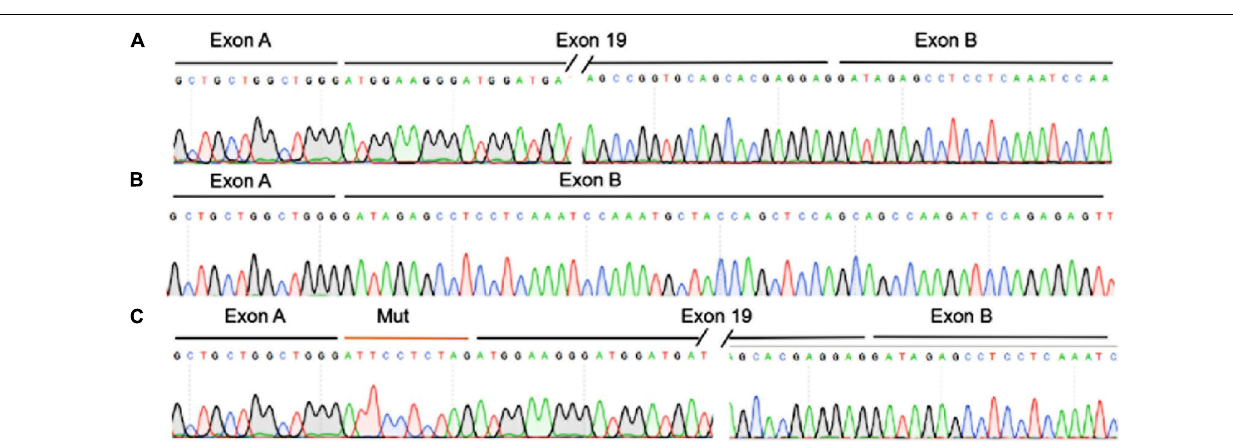
FIGURE 2 | The TJP2 c.2668-11A > G is a new pathogenic variant by inducing abnormal splicing of TJP2 gene. (A) The transcription of TJP2 exon 19 of the wild-type plasmid was validated by minigene assay and sanger sequencing. (B) The transcript of the empty plasmid. (C) The transcription of exon 19 and retained 10 bp intronic region (ATTCCTCTAG) of the mutant plasmid as validated by minigene assay and Sanger